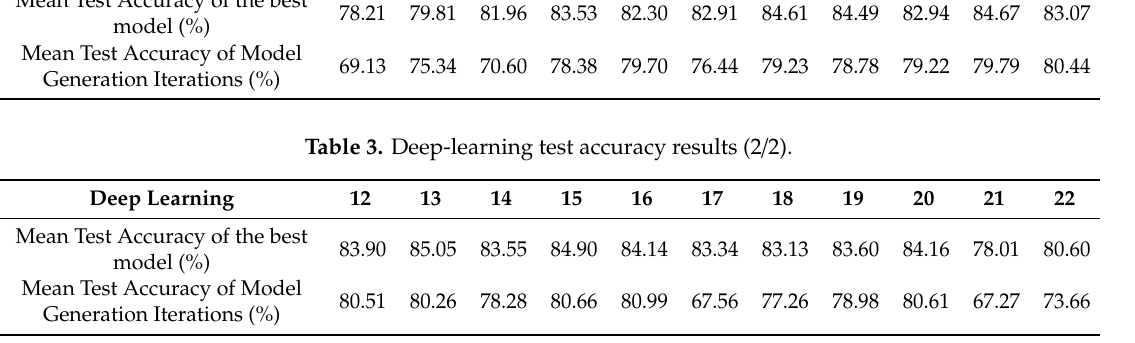
Table 3. Deep-learning test accuracy results (2/2)